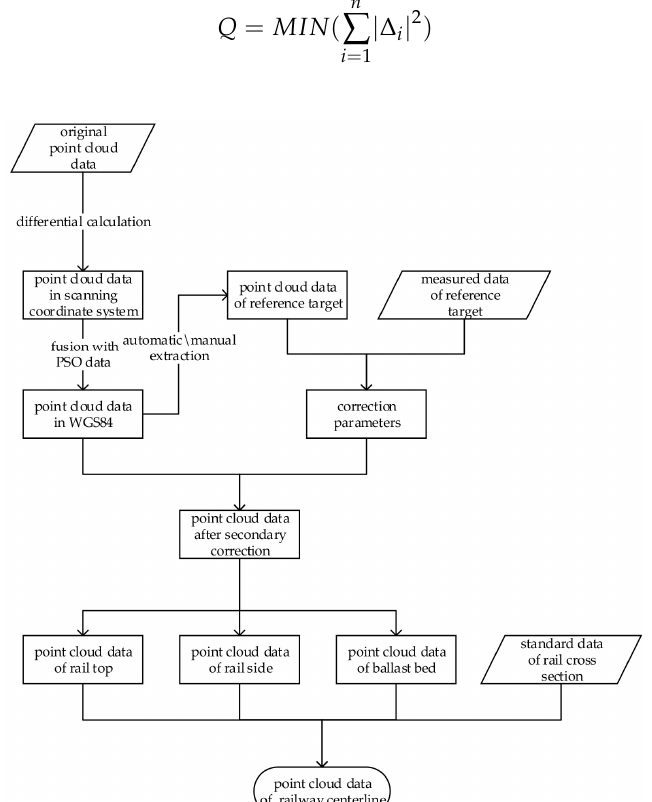
Figure 1. Flowchart for rail centerline extraction.